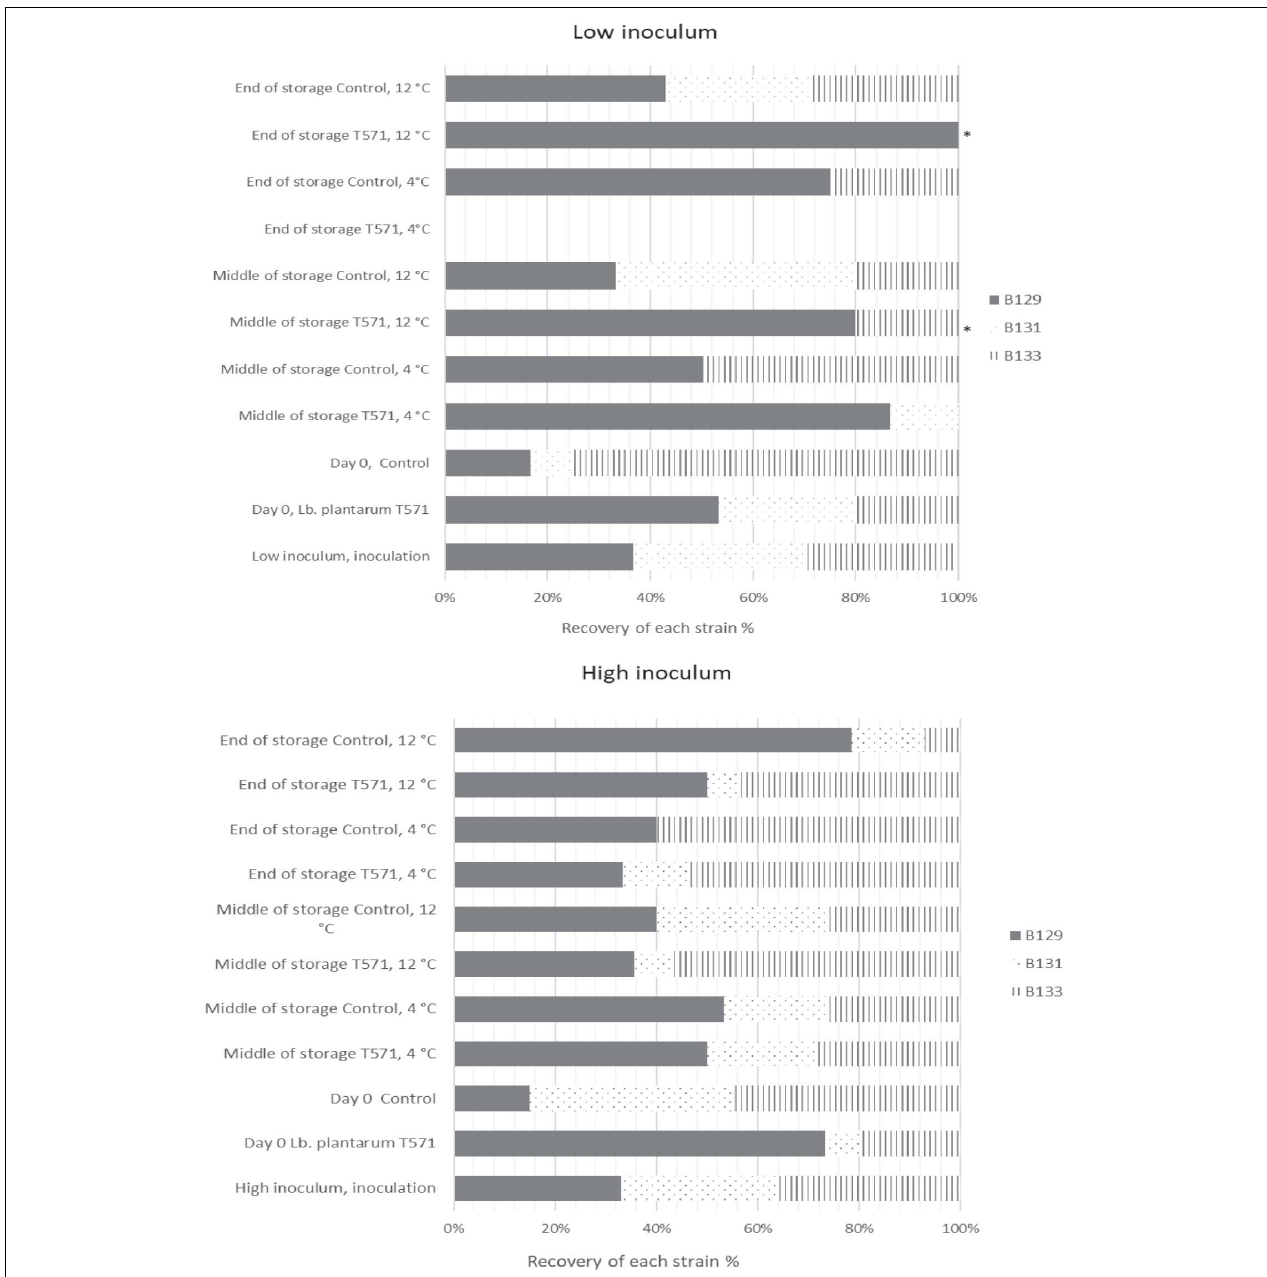
FIGURE 3 | Distribution of Listeria monocytogenes isolates (FMCC-B129: dark shade, FMCC-B131: dots, and FMCC-B133: vertical lines) recovered during storage of yogurt samples based on PFGE profiles for low and high inoculum. ∗ Pathogen detected after applying enrichment